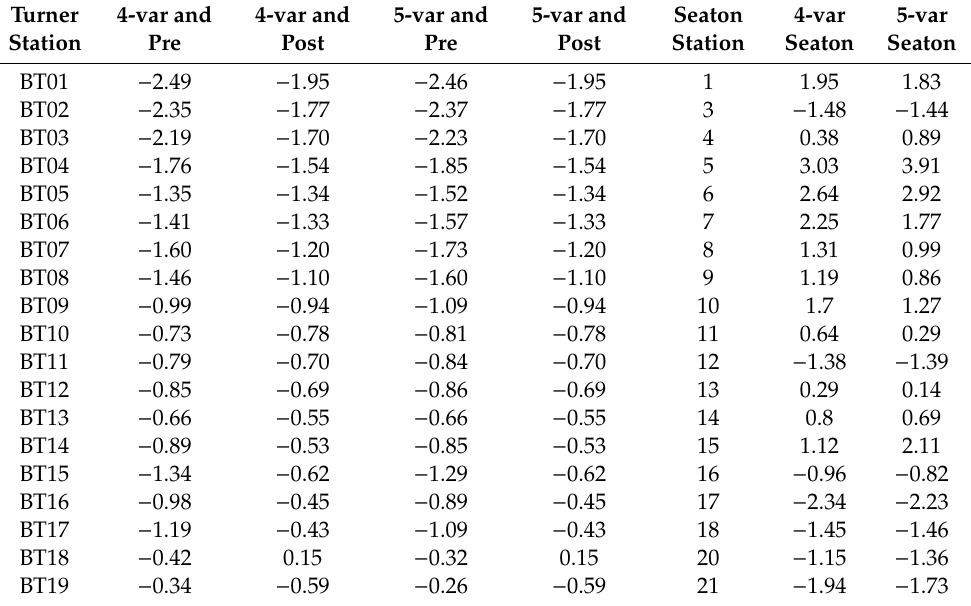
Table 3. Trophic State Index (TSI) scores for 4-variables and 5-variables data.